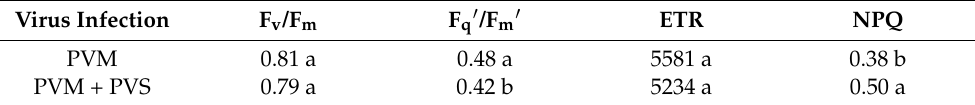
Table 5. Chlorophyll fluorescence parameters as affected by the sanitary status of the plants. Virus Infection F v /F m F q (cid:48) /F m (cid:48) ETR NPQ PVM 0.81 a